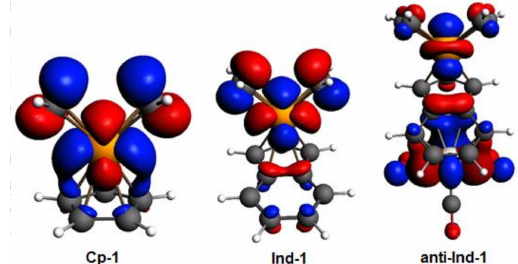
Figure 3. Kohn-Sham HOMOs of Cp-1 , Ind-1 , and anti-Ind-1 ; level of theory: ZORA-BLYP / TZ2P. The isodensity value is